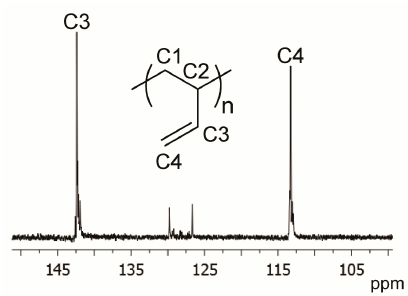
Figure 3. 13 C-NMR spectrum (olefinic region) of polybutadiene of Table 2, run 2.